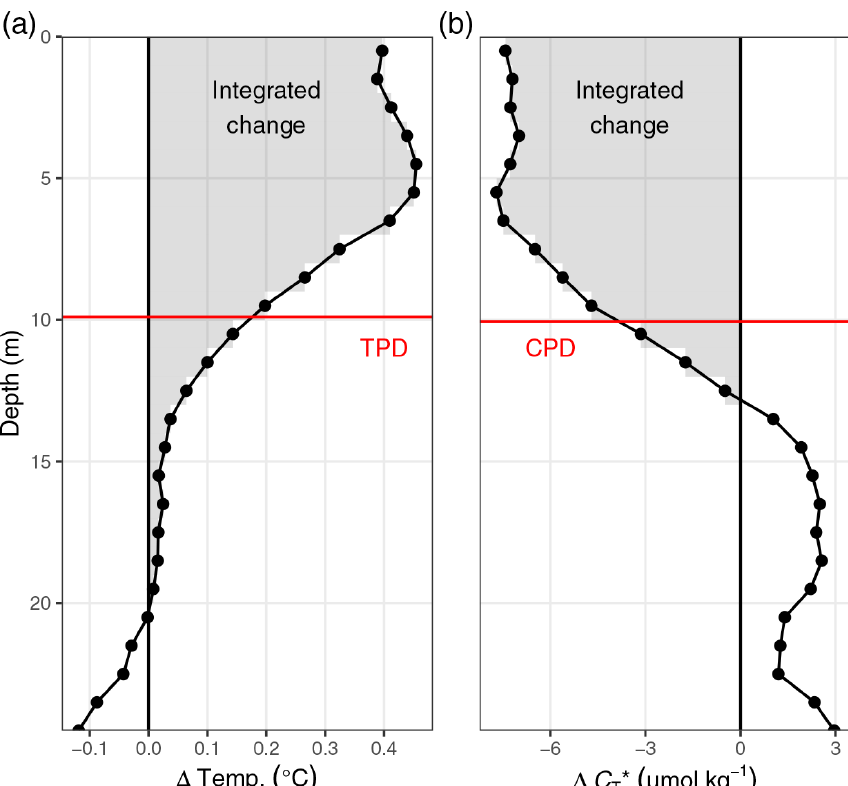
Figure C4. Illustration of the temperature and C ∗ penetration depth concept, short TPD, and CPD. Shown are exemplary profiles of incre- T mental changes of (a) temperature and (b) C ∗ observed between the cruises on 6 and 10 July. TPD and CPD (red horizontal lines) are defined T as the depth-integrated positive (for temperature) and negative (for C ∗ ) changes (grey areas) divided by the change at the surface. TPD and T CPD are expressed in units of